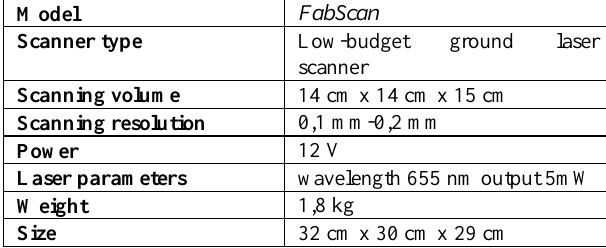
Table 1. Basic technical parameters of FabScan scanner